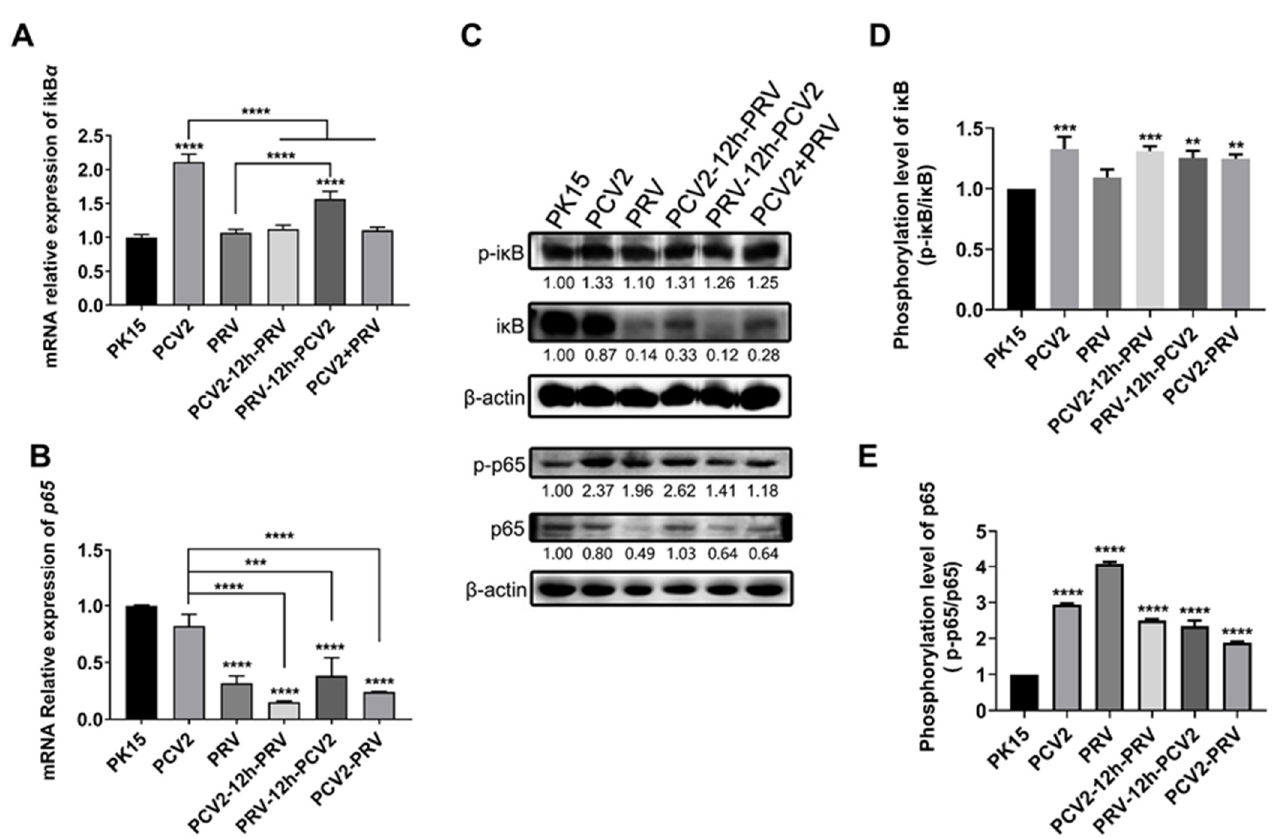
Figure 5. Coinfection of PCV2 and PRV modulates the NF- κ B signal pathway. ( A , B ) Expression levels of i κ B and p65 . The relative mRNA levels of i κ B ( A ) and p65 ( B ) were examined using real-time PCR. The data are presented as the means ± SD. **, p -value < 0.01; ***, p -value < 0.001; ****, p -value < 0.0001. ( C – E ) Protein levels of p65 and i κ B. Western blotting was conducted using P-IKB α (Ser32 Ser36), IKB- α , NF κ B p65 Polyclonal Antibody, Phospho-NF κ B p65 (Thr276) Polyclonal Antibody, and Anti- β -Actin Antibody as primary antibody, respectively. HRP-labeled Goat Anti-mouse IgG (H+L) and HRP-labeled Goat Anti-rabbit IgG (H+L) were used as the secondary antibody. β -actin was used as a control. The average expression level of the target protein in each group is shown below each lane. The protein amount of the PK-15 group is set to 1, and the values of other groups are the ratio with the PK-15 group. Unprocessed original images can be found in Supplementary Figure S4.